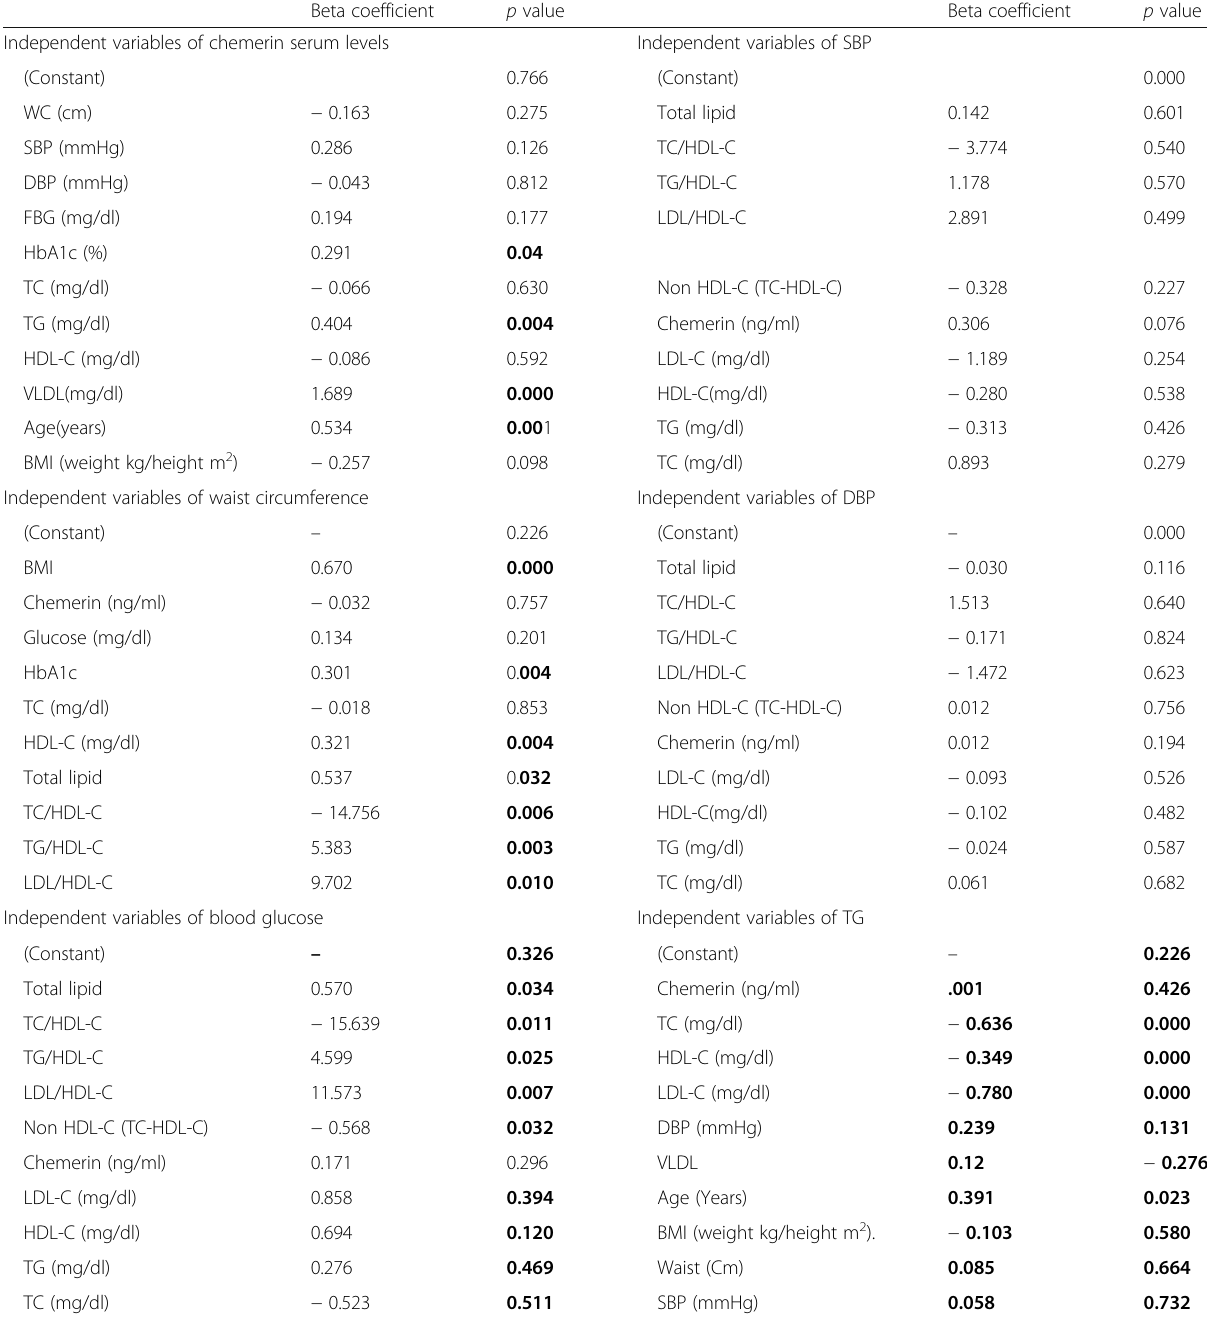
Table 3 Multiple linear regression analysis of the predictor variables of serum chemerin, waist circumference, systolic blood pressure, diastolic blood pressure, triglyceride levels, and fasting blood glucose in MetS